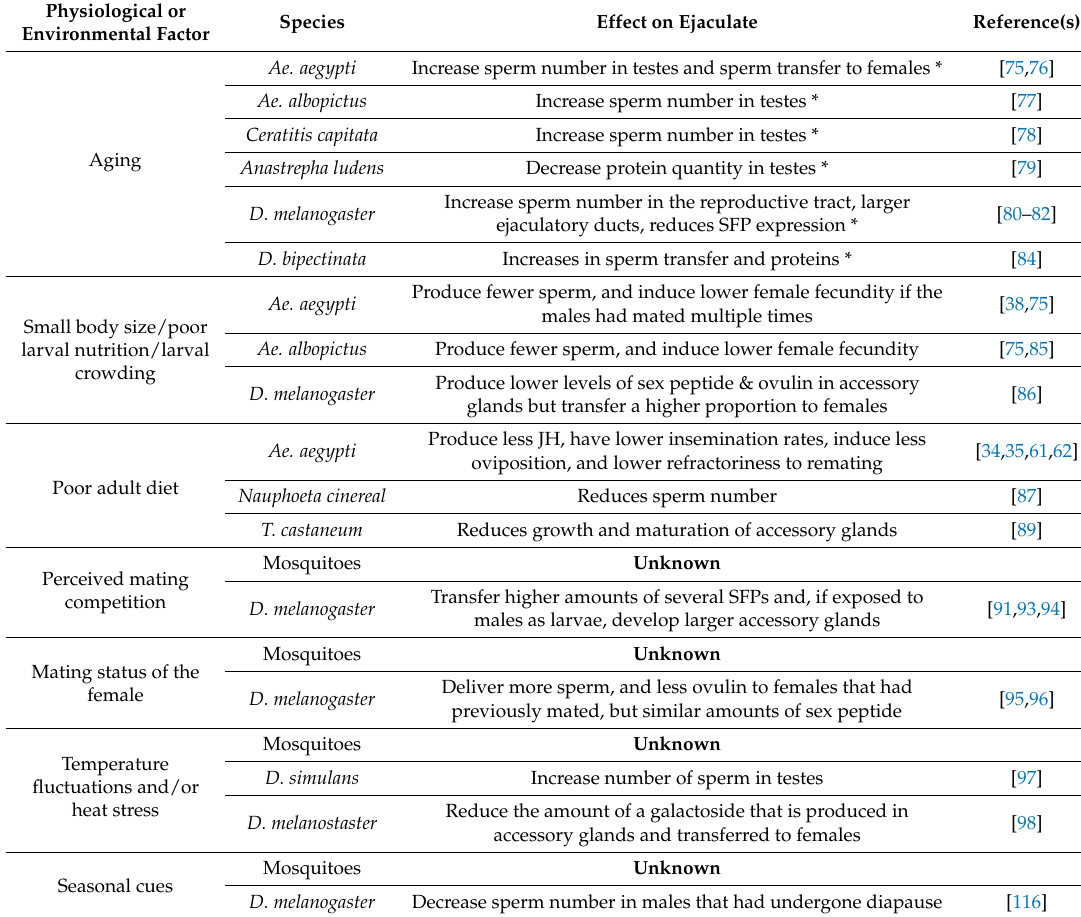
Table 1. The effects of biotic and abiotic factors on the ejaculate of various insect species. Physiological or Environmental